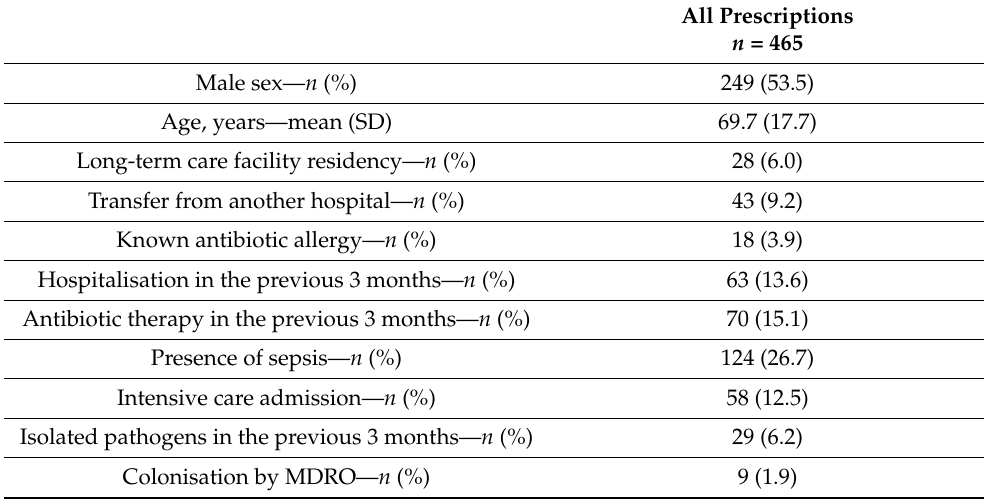
Table 1. Patient’s demographic and clinical